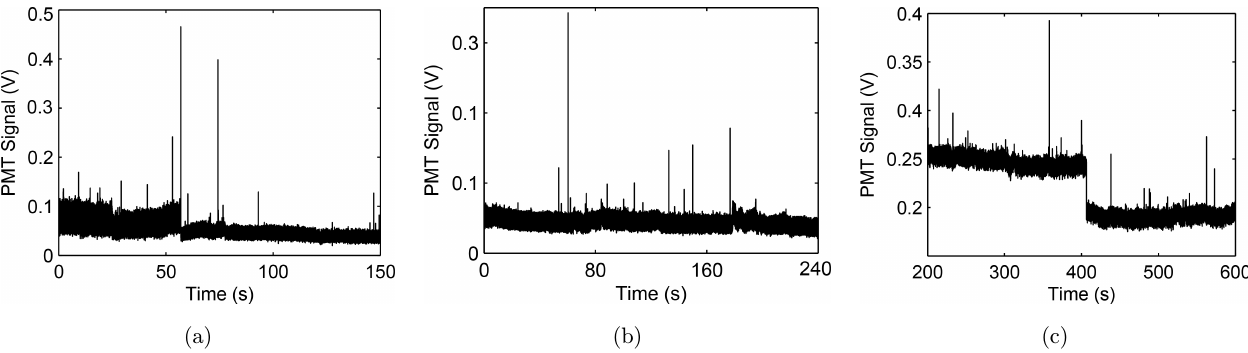
Fig. 2. Representative IVFC signals with baseline drift. (a) A signal with noise bandwidth change since 57 s. (b) A signal has the problem of gentle baseline °uctuation. (c) An abrupt baseline change occurred at 406 s in the